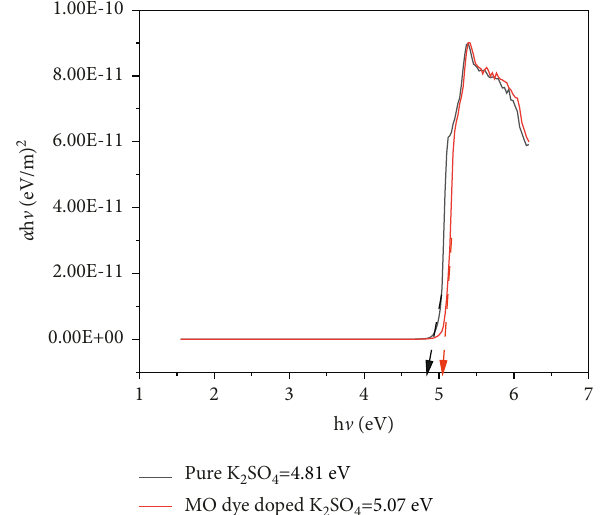
Figure 4: Band gap spectra of pure and doped K